Question: What type of chart is this?
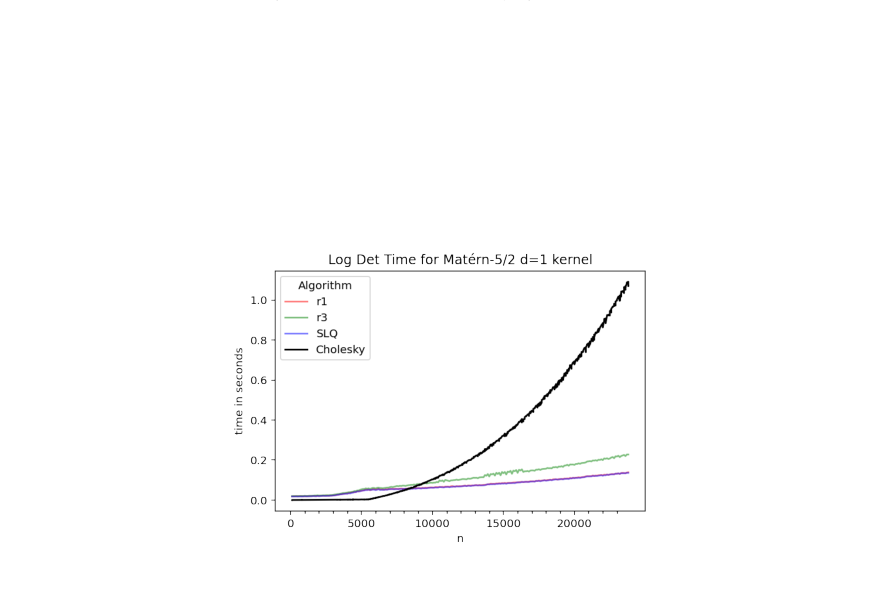
Answer: line